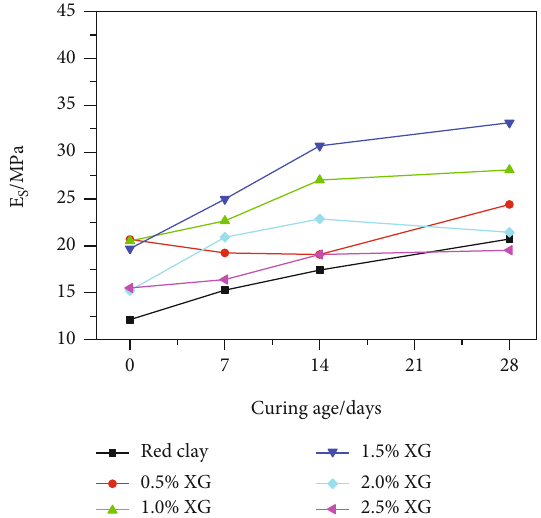
Figure 5: Relationship of xanthan gum content and compression